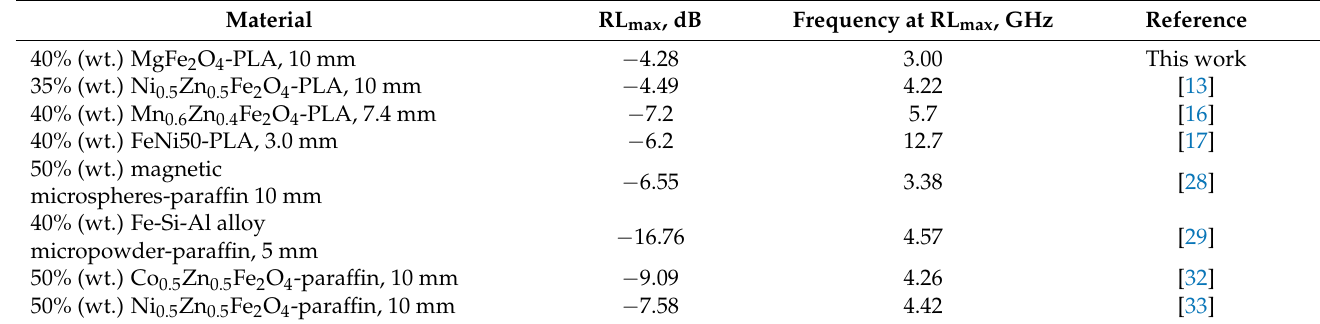
Table 4. Microwave absorption characteristics of magnetodielectric composites.